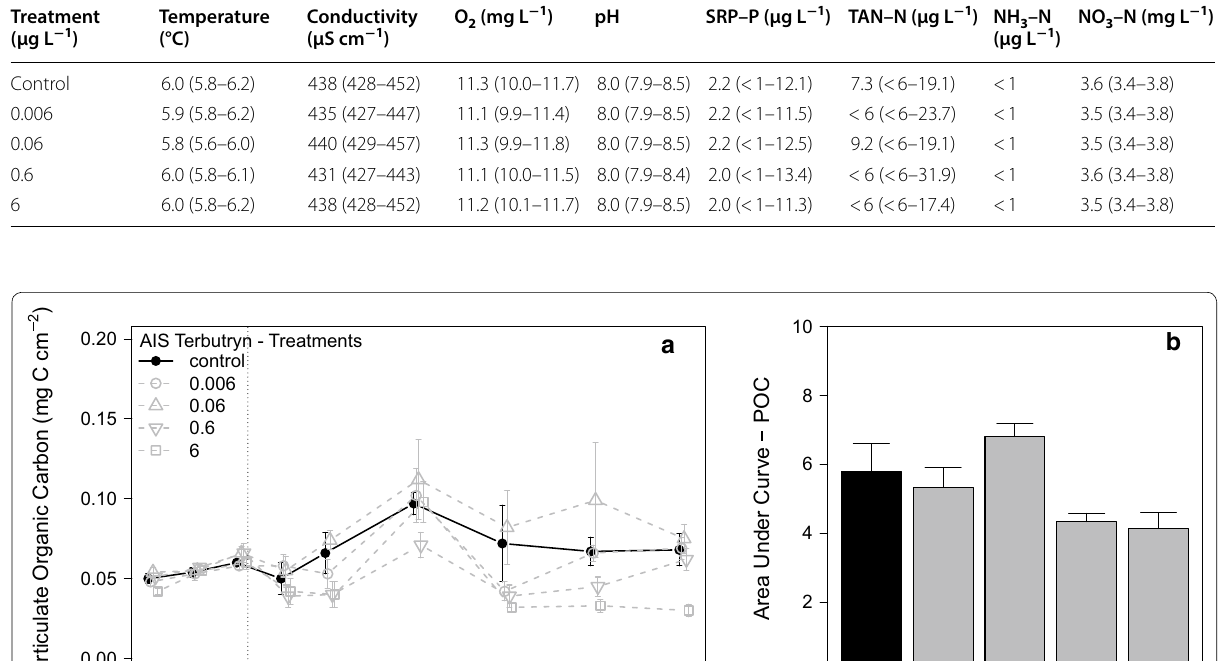
SE, n 6]. d d ± = − 15 − − 1 pre-application period, d